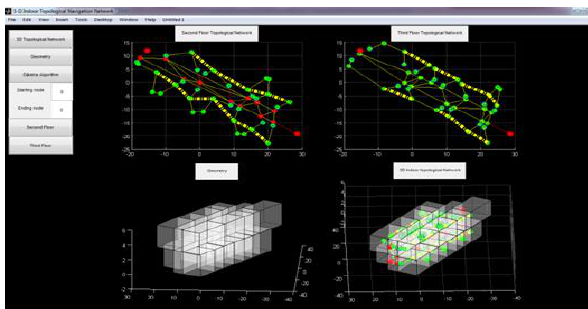
Figure 9. Rapid indoor data structure and navigational network.